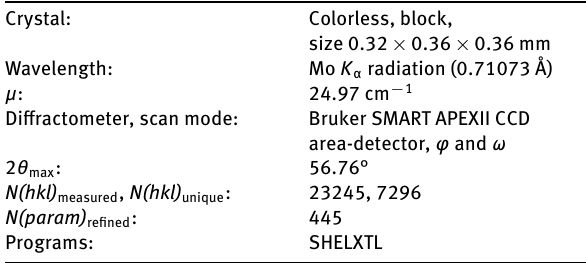
Table 1: Data collection and handling.